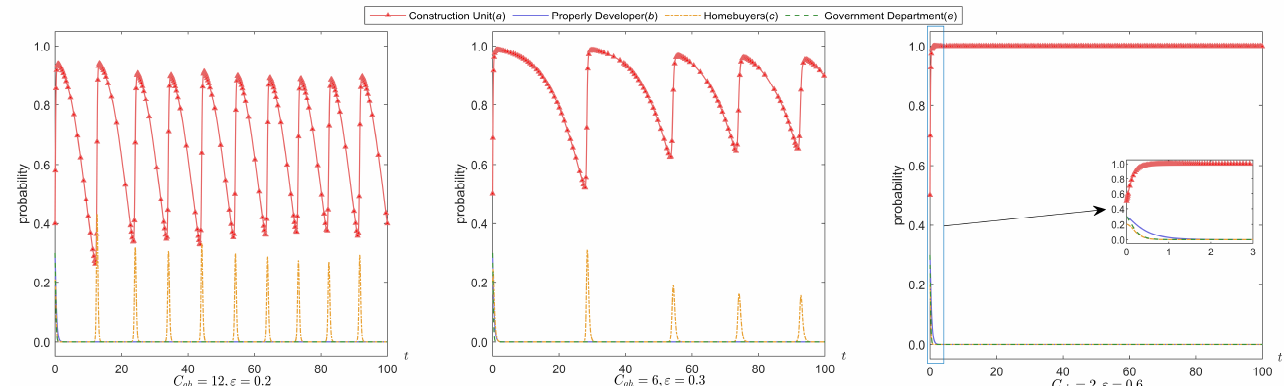
Figure 10. Impact of supervision costs of the government and the involvement of supervision consulting company.